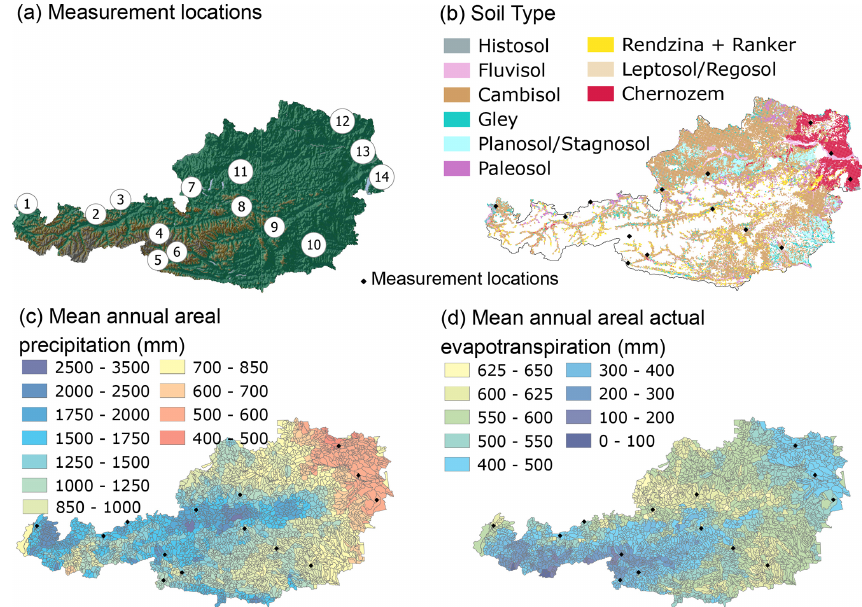
Figure 1. Panel (a) outlines the locations of the following 14 monitoring sites in Austria: (1) Lauterach, (2) Leutasch, (3) Achenkirch, (4) Gschlössboden, (5) Sillianberger Alm, (6) Zettersfeld, (7) Elsbethen, (8) Gumpenstein, (9) Aichfeld-Murboden, (10) Kalsdorf, (11) Pet- tenbach, (12) Schalladorf, (13) Lobau, and (14) Frauenkirchen. Panel (b) provides the soil map data basis: digital soil map of Austria, 1km raster, Federal Forest Research Center (BFW, 2016). Panel (c) shows the Hydrological Atlas of Austria (HAO) mean areal annual precipi- tation (Kling et al., 2007b), and panel (d) shows the HAO mean areal annual actual evapotranspiration (Kling et al., 2007a); maps from the HAO where compiled using QGIS (QGIS Development Team,